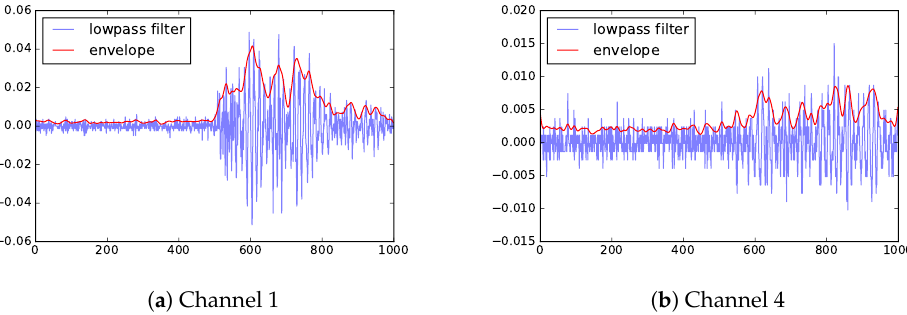
Figure 5. Envelope of two sample data sets. The horizontal axis is time steps (where each step is 0.4 ns) and the vertical axis shows UHF measurements (blue) along with envelope (red) (in